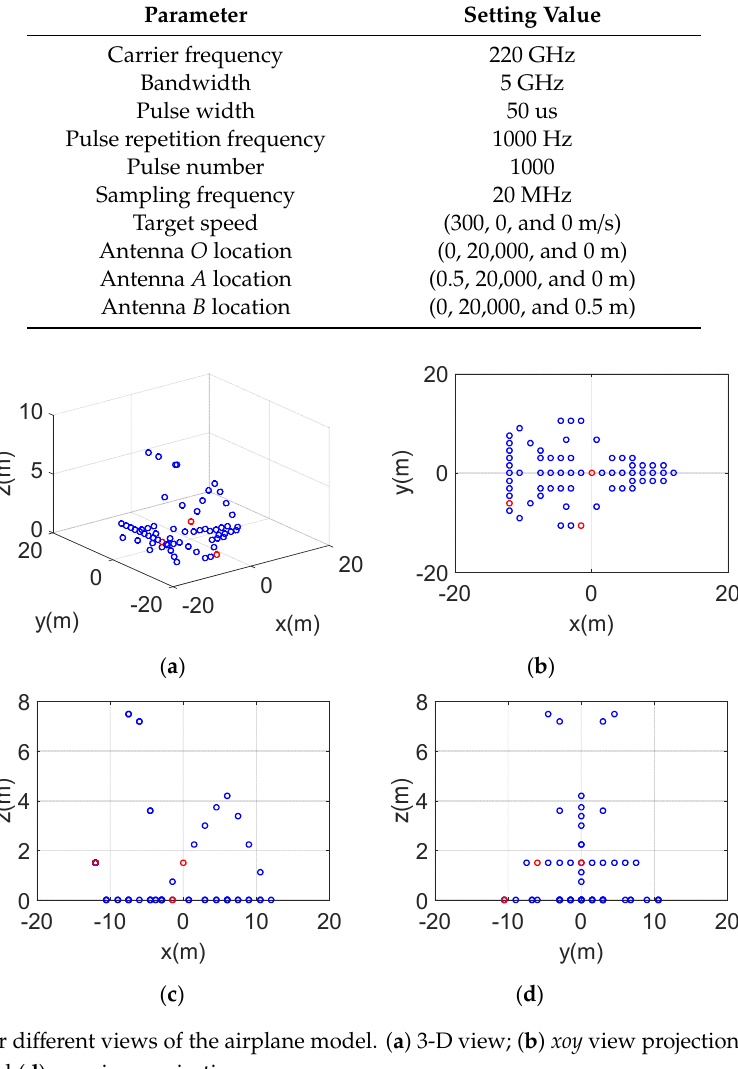
Table 1. Parameter settings of the radar system and target.